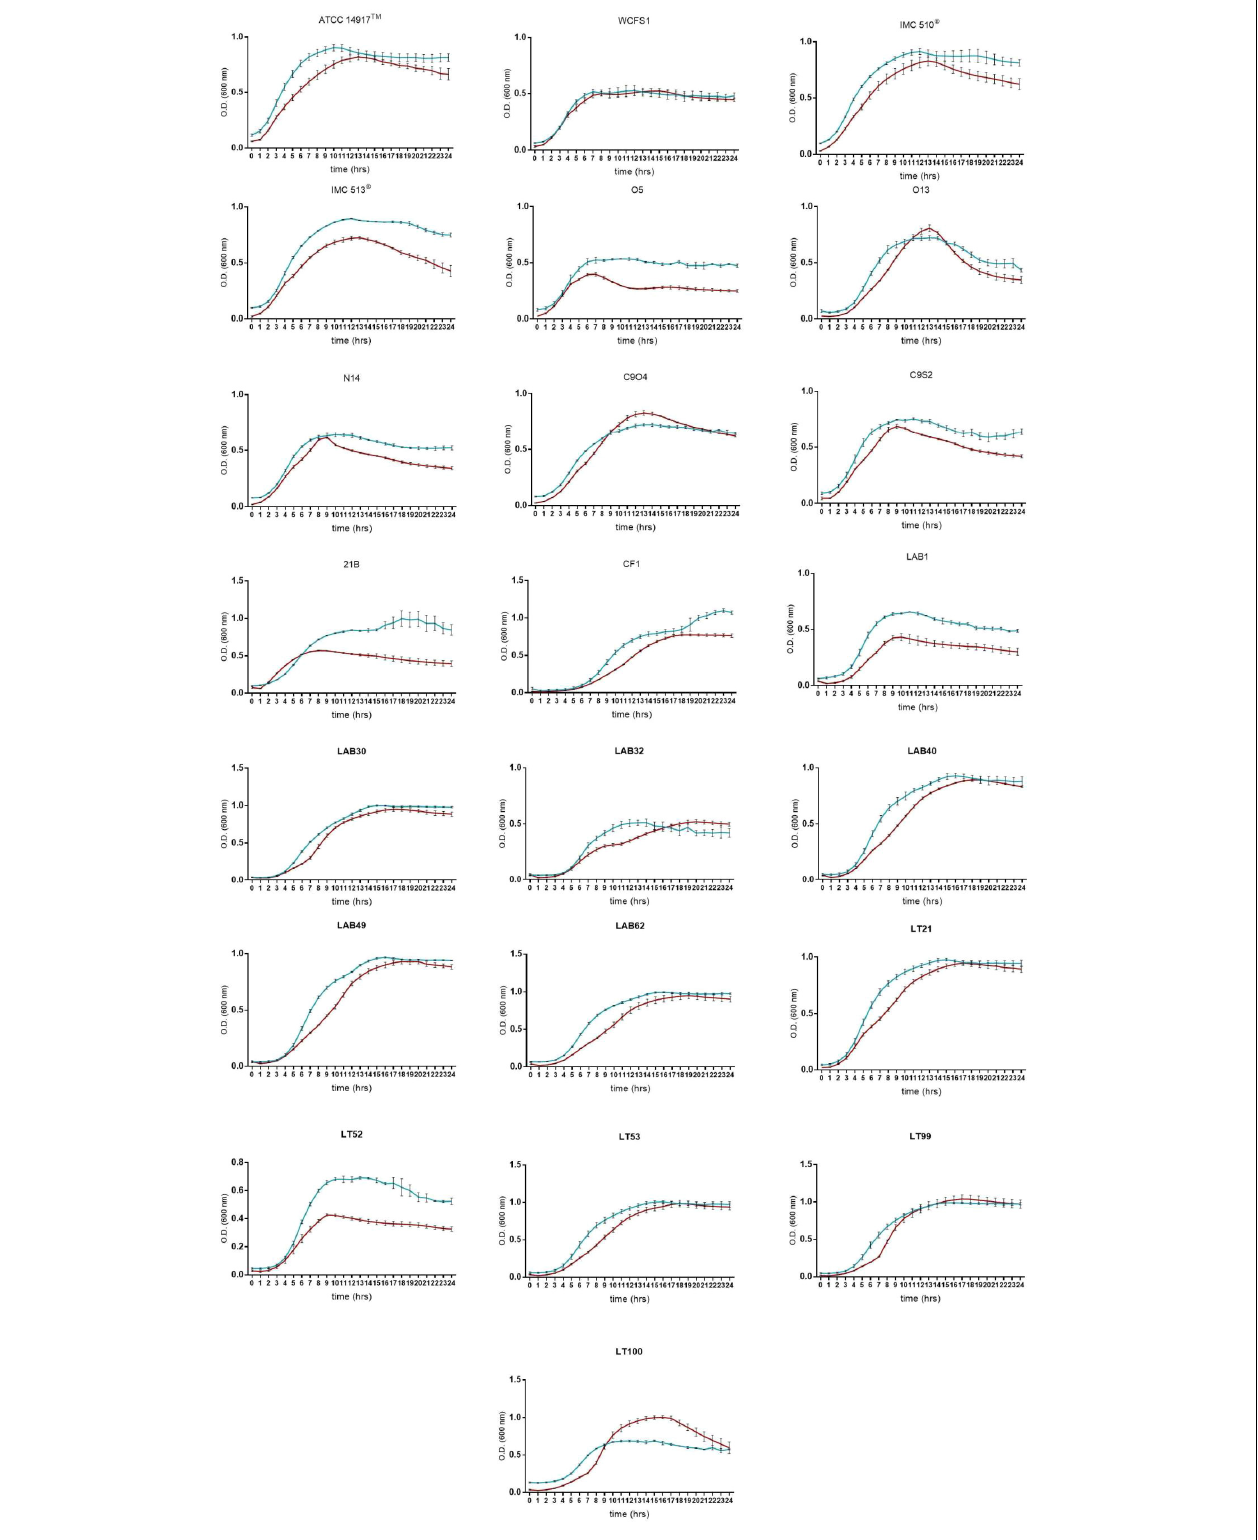
FIGURE 7 | Lactobacillus plantarum growth curves in presence of porcine mucin (dark red line means MRS broth, blue lines means MRS broth with porcine mucin (0.1% w/v). Data are reported as mean values ± SEM from three biological replicates.